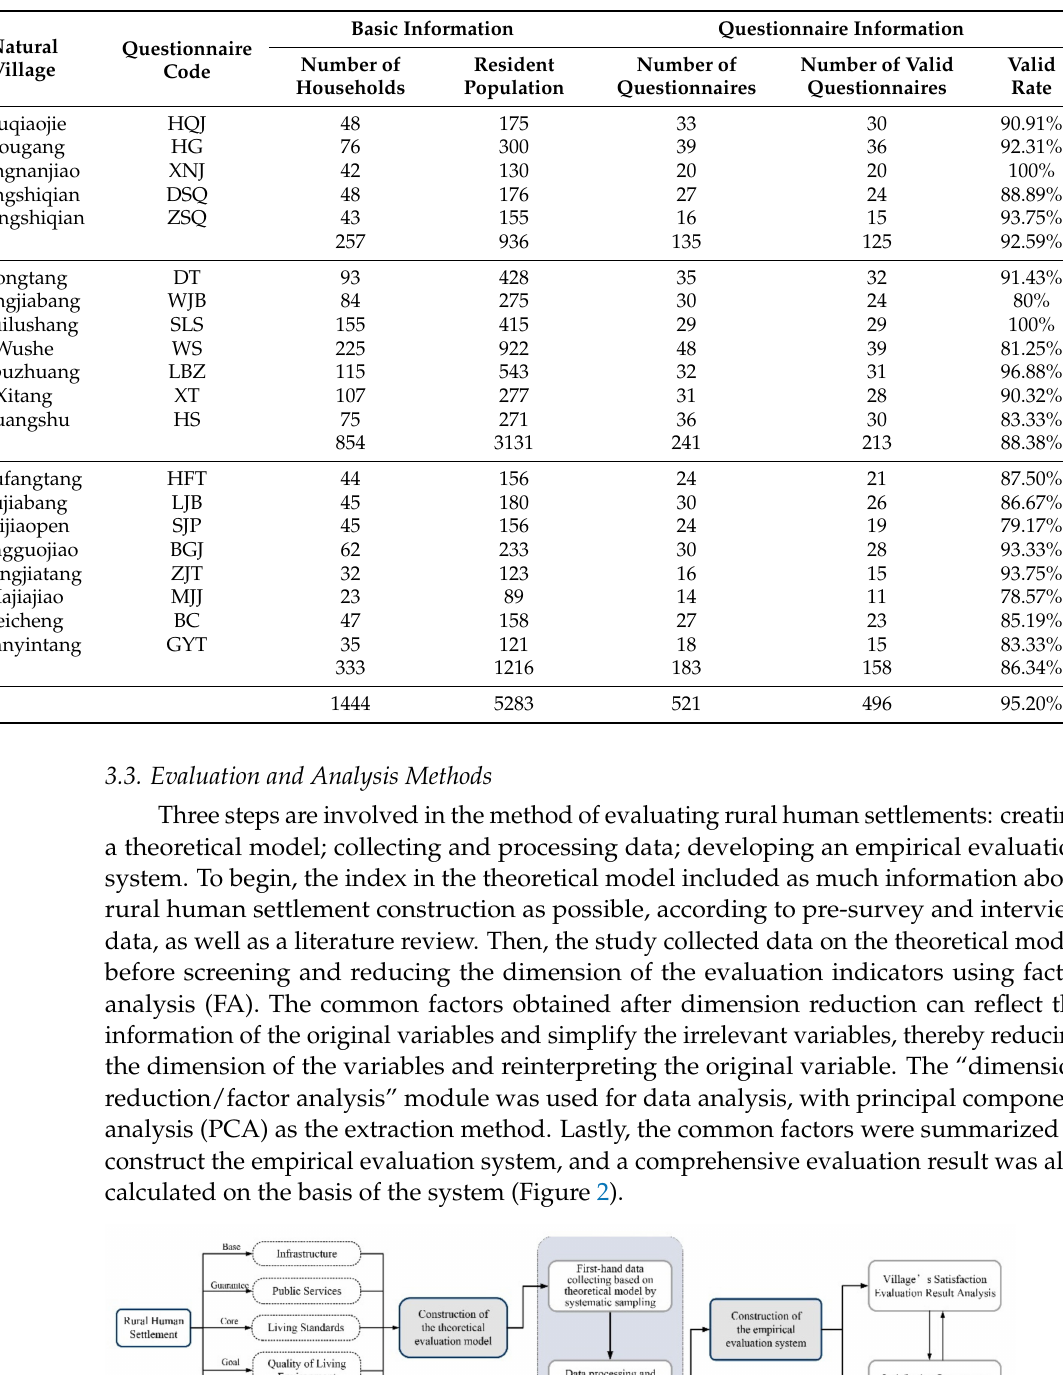
Table 1. Information about the survey area and questionnaire.